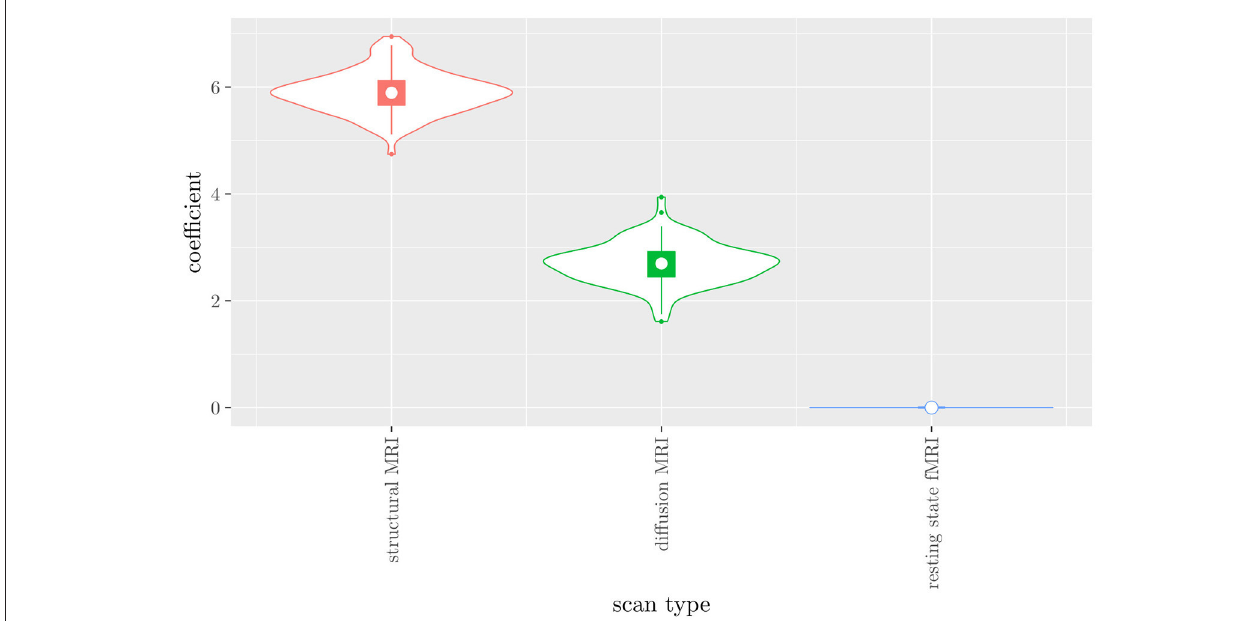
FIGURE 4 | Box-and-violin plots of the regression coefficients of StaPLR applied with only 2 levels, using the scan types as